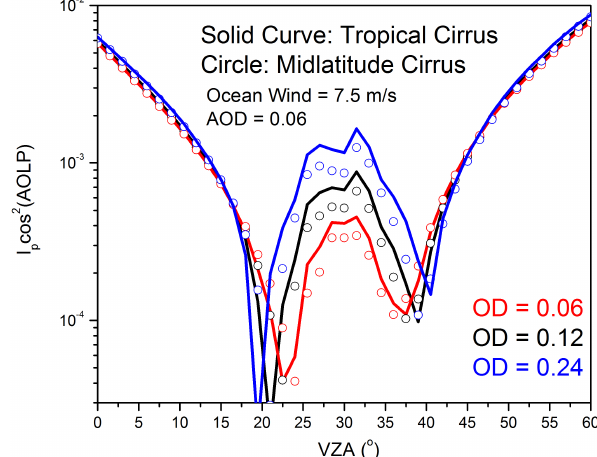
Figure 9. Modeled p-polarized reflectance at a wavelength of 670nm as a function of viewing zenith angle (VZA), and at a rela- tive azimuth angle (RAZ) of 177 ◦ for super-thin cirrus clouds over oceans with different optical depth (OD). In the modeling, the solar zenith angle (SZA) is 29.17 ◦ , the wind speed is 7.5ms − 1 , and the aerosol optical depth (AOD) is 0.06. The size distribution of the ice particles in the cirrus clouds is from Heymsfield and Platt (1984) for the cloud temperature of − 20 to − 25 ◦ C. The clouds are composed of mixtures of complex particle shapes for typical mid-latitude cir- rus clouds as described in Baum et al. (2000) (open circles) and tropical cirrus clouds as described in Meyer et al. (2004) (solid curves). This illustrates that with inadequate knowledge of cloud particle shapes, uncertainties of up to ∼ 0.05 in the retrieved cloud OD can be